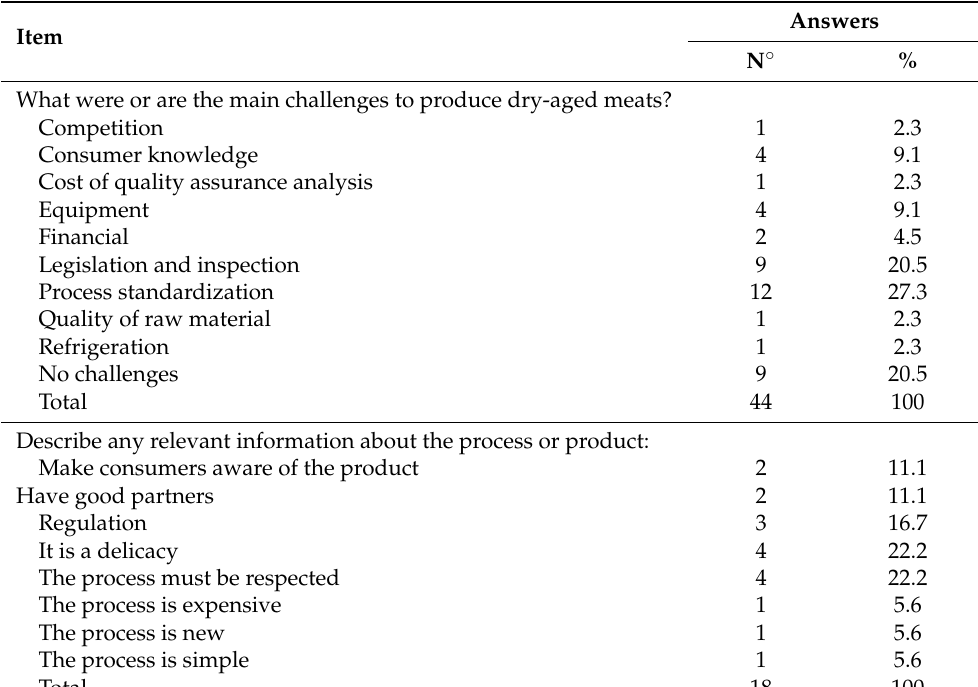
Table 10. Final considerations of dry-aged meat producers in